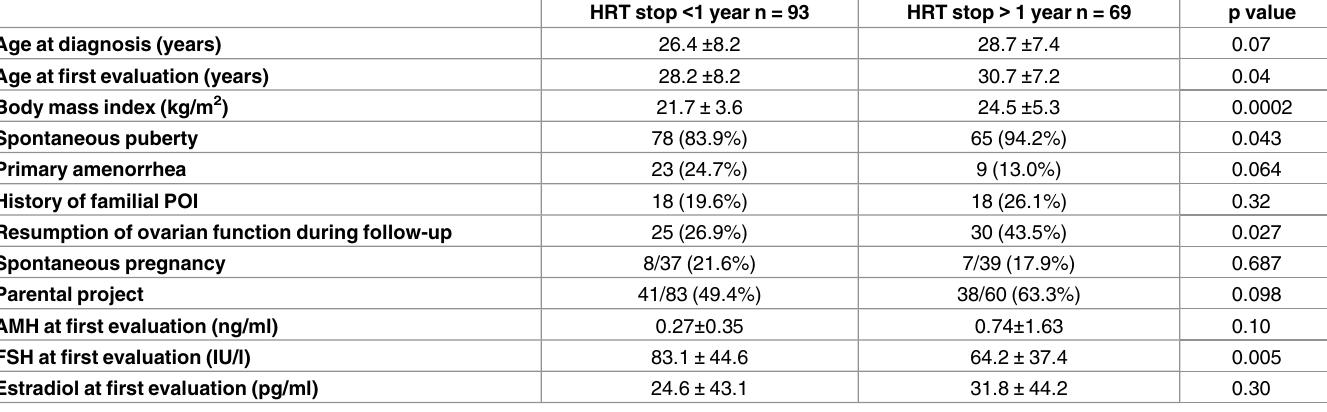
Table 2. Comparison of women who stopped or continued their